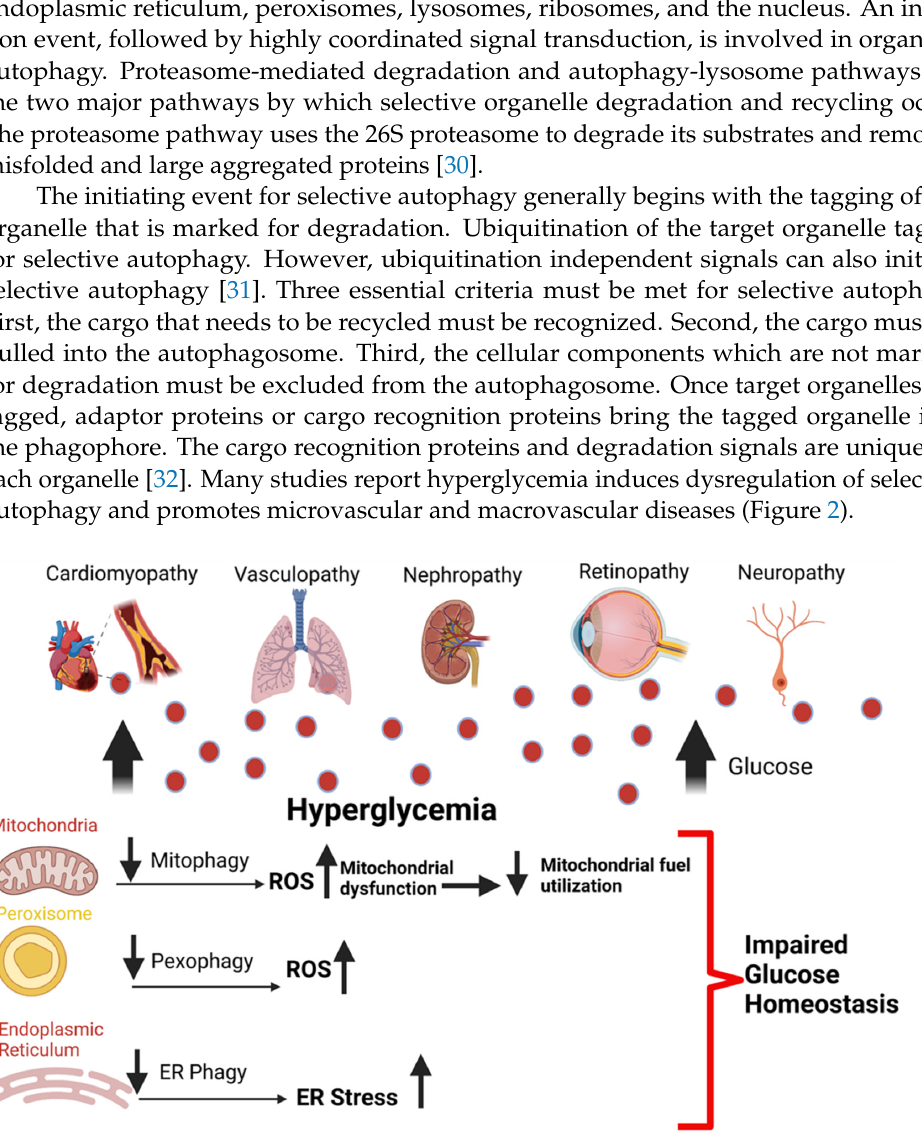
Figure 2. Hyperglycemia dysregulates selective autophagy and promotes diabetic complications. Hyperglycemia induced organelle dysfunction promotes cellular dysfunction. Impaired mitophagy promotes excessive mitochondrial ROS pro- duction, impaired mitochondrial energy metabolism, and fuel utilization. Peroxisomal damage results in failure of the redox system within the organelle, dysregulation of fatty acid oxidation, and impaired import of proteins. Protein mis- folding within the endoplasmic reticulum (ER) causes the unfolded protein response, which induces ER stress. Hypergly- cemia stalls the clearance of the damaged and dysfunctional organelles due to inefficient autophagy. Impaired fusion of the autophagosome with the lysosome, decreased lysosomal acidification, and efficiency leads to the accumulation of dysfunctional organelles, resulting in an unhealthy cellular milieu, promoting diabetic macrovascular and microvascular complications. 2. Mitophagy Mitochondria are essential for regulating cellular energy generation, homeostasis, re- dox signaling, programmed cell death, and immunity. Dysregulation of mitochondrial function, damage to the mitochondrial structure, or adverse changes in mitochondrial dy- namics can cause diabetic complications. Mitophagy is the selective removal of mitochon- dria by the autophagic machinery. When mitochondria are damaged or dysfunctional, mitophagy plays a crucial role in clearing the mitochondria and restoring cellular home- ostasis. There are three types of mitophagy. In type 1 mitophagy, mitochondrial fission occurs, followed by the sequestration of the mitochondria into mitophagosomes. Mito- chondrial membrane depolarization does not occur until after the mitochondria are se- questered into the mitophagosome. Hence, PINK1/Parkin signaling may or may not be involved in type 1 mitophagy. PTEN-Induced Kinase 1(PINK1), is a mitochondrial serine- threonine protein kinase. PINK1 activity causes the E3 ubiquitin ligase; Parkin to localize on the depolarized mitochondrial membrane to induce mitophagy. In type 2 mitophagy, mitochondrial fission does not appear to be crucial. However, a continuous fusion of mi- tophagosomal membrane occurs with LC3, located on the depolarized mitochondria, con- sistent with the fusion of the mitochondrial membrane with the autophagosome mem- brane. In type 2 mitophagy, mitochondrial membrane depolarization precedes sequestra- tion, and PINK1/parkin is involved. Type 3 mitophagy involves the formation of mito- chondria-derived vesicles (MDV). The MDV undergoes fission and bud off from the mi- tochondrial surface. However, the budding off of the MDV does not require the partici- pation of dynamin-related protein 1(Drp1), which is necessary for the binary fission of the mitochondria. PINK1/parkin is involved in type3 mitophagy, as the MDV is depolarized before undergoing mitophagy. The MDV contains the oxidized mitochondrial proteins,